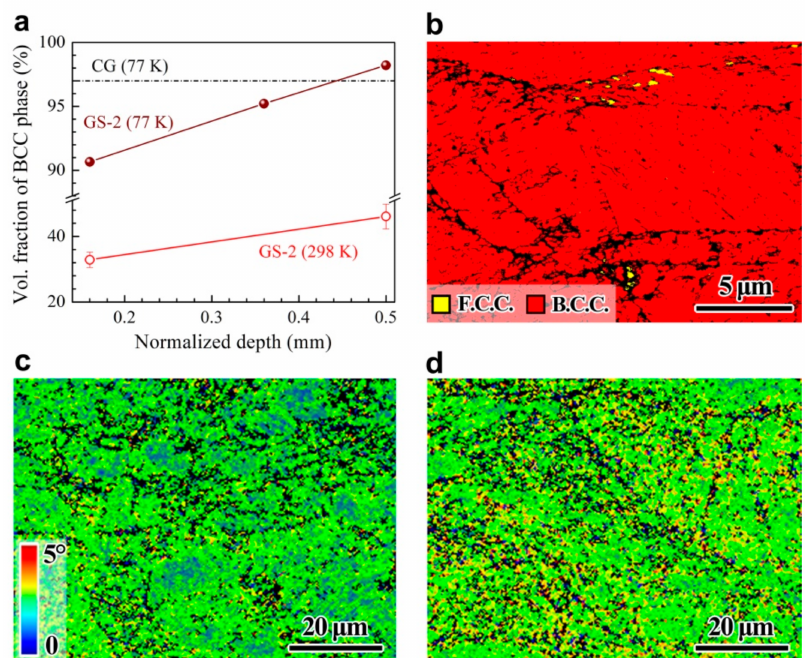
Figure 8a, in which the volume fraction of martensitic transformation for the CG sample during testing at cryogenic temperature is marked by a dash line. Compared to testing at room temperature, the martensitic transformation is more obvious after testing at cryogenic temperature for all depths, resulting in stronger strain hardening for the gradient structures. The amount of martensitic transformation at the central layer of the GS2 sample is observed to be even higher than that for the CG sample at cryogenic temperature. This might be one of the origins for the simultaneous improvement strength and ductility by the gradient structures at cryogenic temperature. Moreover, the phase and KAM mappings of the CG sample after tensile testing at cryogenic temperature are shown in Figure 8b,c, respectively.